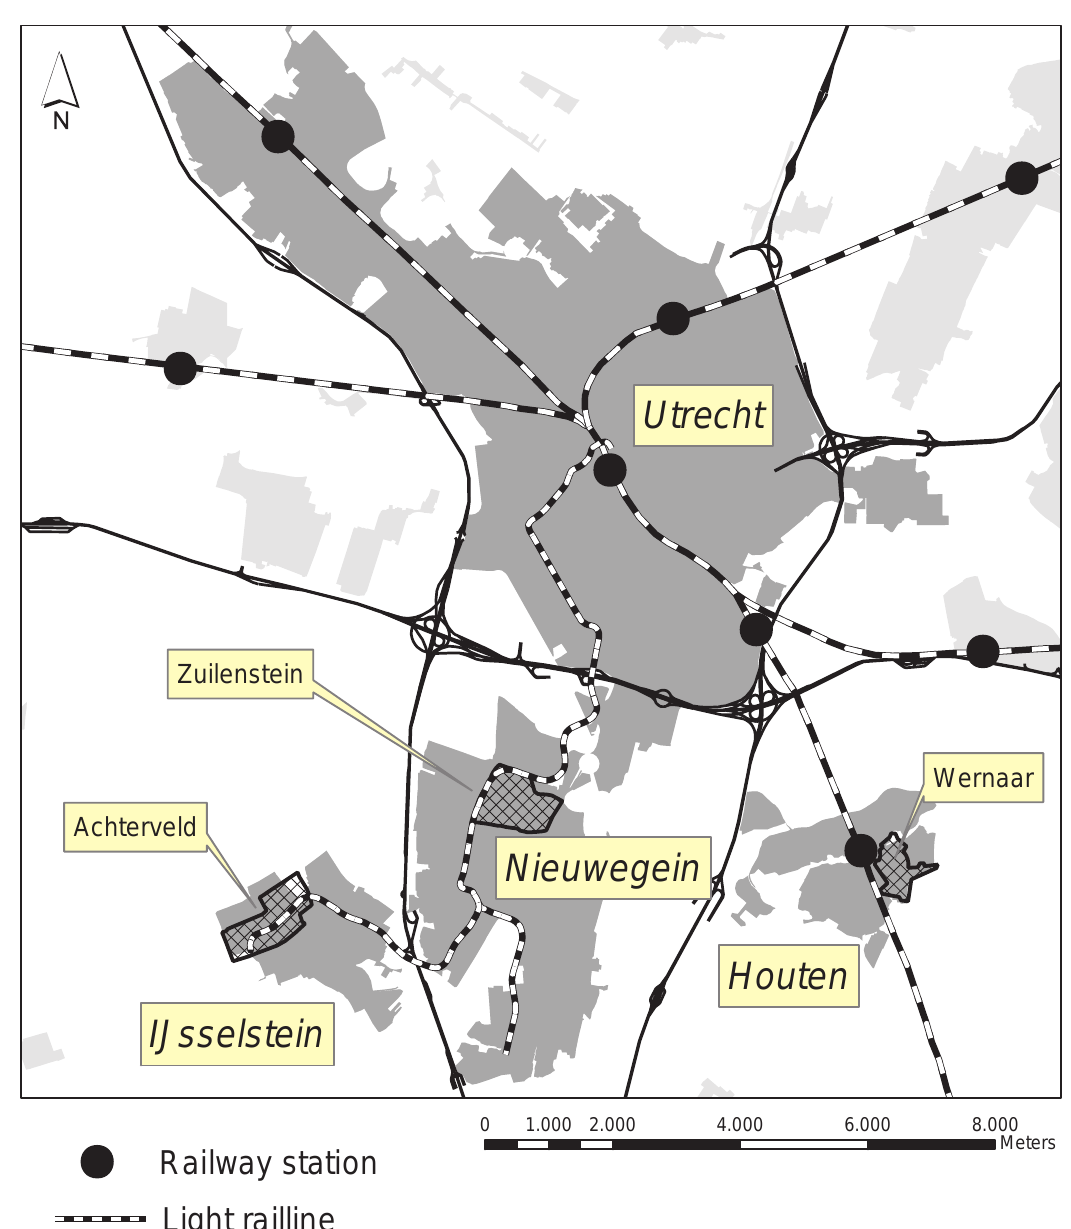
Figure 1: Situation of neighbourhoods in the region of